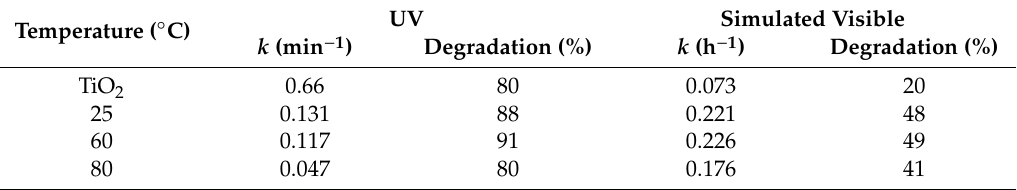
Table 2. Apparent reaction rates (k) for photocatalytic degradation of CIP (5 mg / L) with bare TiO 2 and Au / TiO 2 nanocomposite synthesized at di ff erent temperatures, over 30 and 180 minutes of UV and simulated visible radiation, respectively. The Au loading of 0.05 wt. % was used for the tested materials. Temperature ( ◦